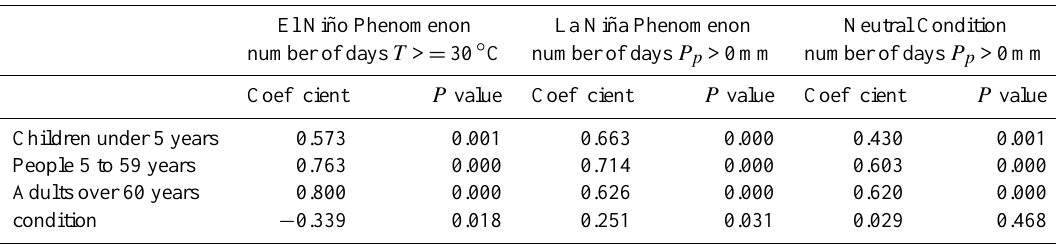
Table 4. Spearman’s correlation analysis between diarrhoea diseases and total days with temperatures above 30 ◦ C and days with precipitation nonzero in Aguascalientes, Mexico from